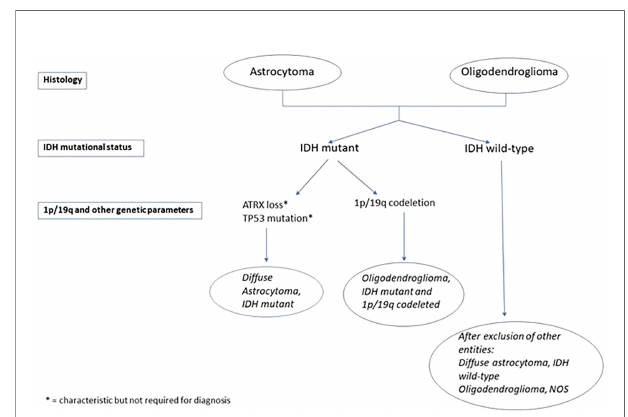
FIGURE 1 | Molecular pathways of IDH-mut lower-grade gliomas development. IDH1 /2 mutations are early events in glial progenitors after which these cells acquire additional mutations: ATRX and TP53 mutations in astrocytomas, and 1p/19q co-deletion and pTERT mutations in